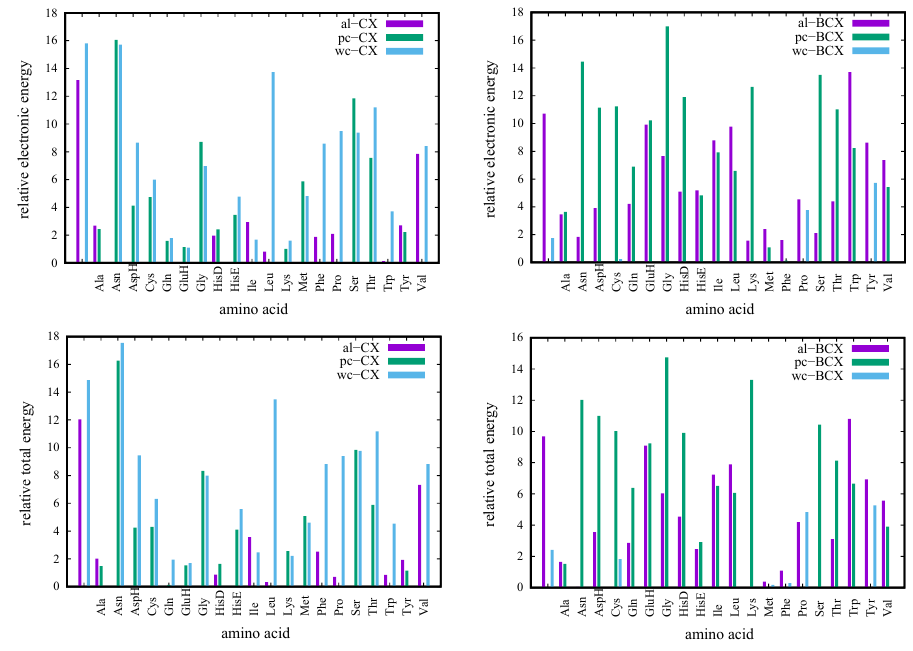
Figure 4. Relative total and electronic energies for complexes with three conformers of calix[6]arene and hexa- p - tert -butylcalix[6]arene. Energies are in